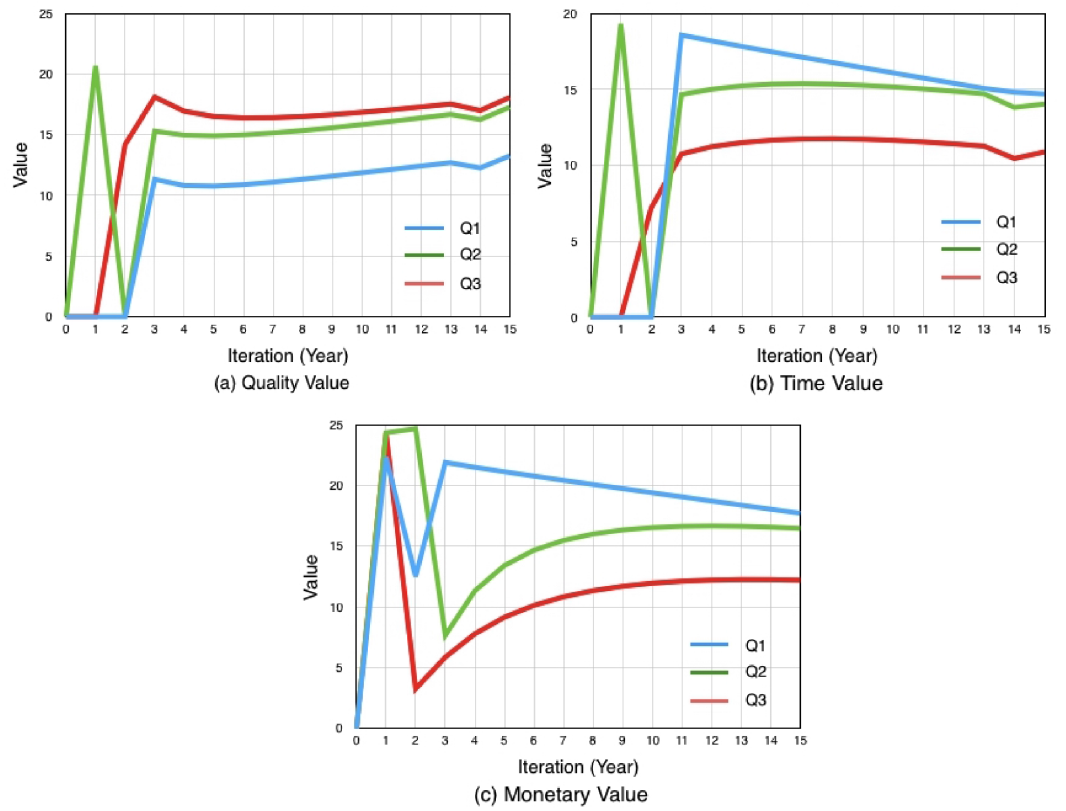
Figure 7. Value Generated in Implementation Stage: (a) Quality Value, (b) Time Value, and (c) Monetary